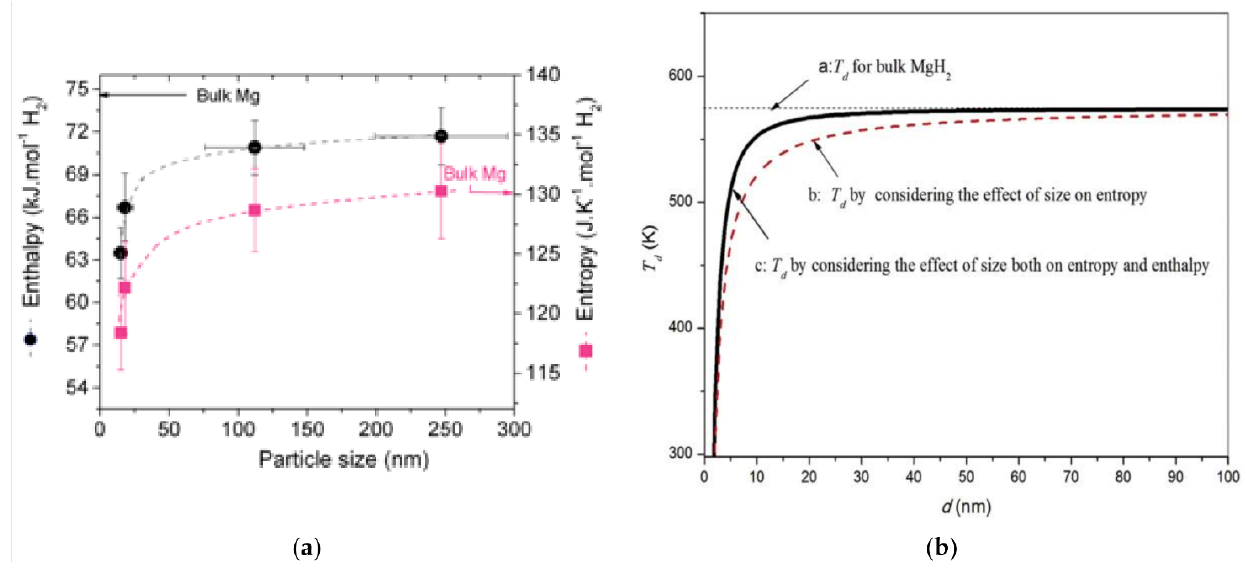
Figure 41. ( a ) Associated evolution of ∆ H and ∆ S versus the size of the magnesium nanoparticles. The dot line is a guide to the eye. Reproduced with permission [305]. Copyright 2014, Royal Society of Chemistry. ( b ) The curve of dehydrogenation temperature under 1 atm depended on grain size/particle size. Reproduced with permission [296]. Copyright 2017,